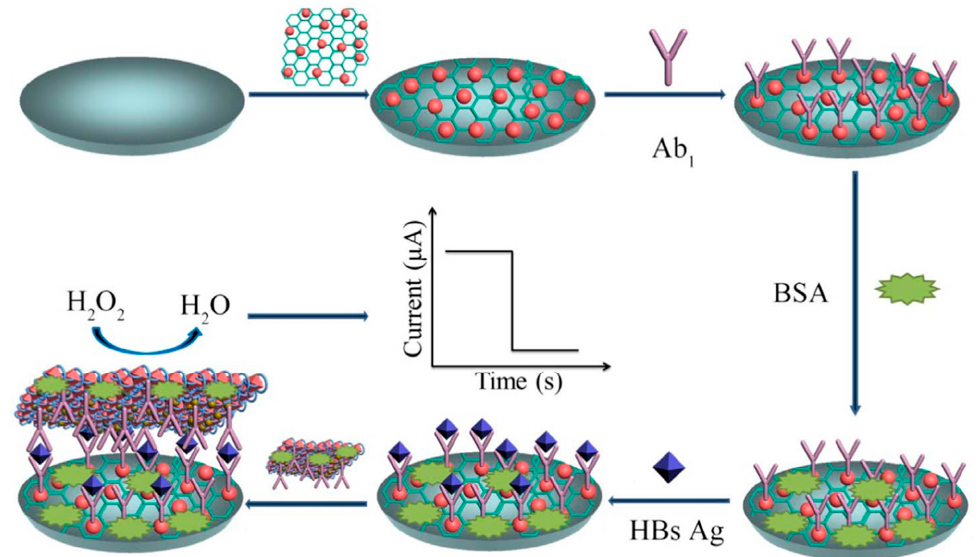
Figure 18. The schematic of the proposed sandwich-type immunosensor, based on MoS 2 @Cu 2 O-Pt [123]. Copyright: Elsevier B.V.